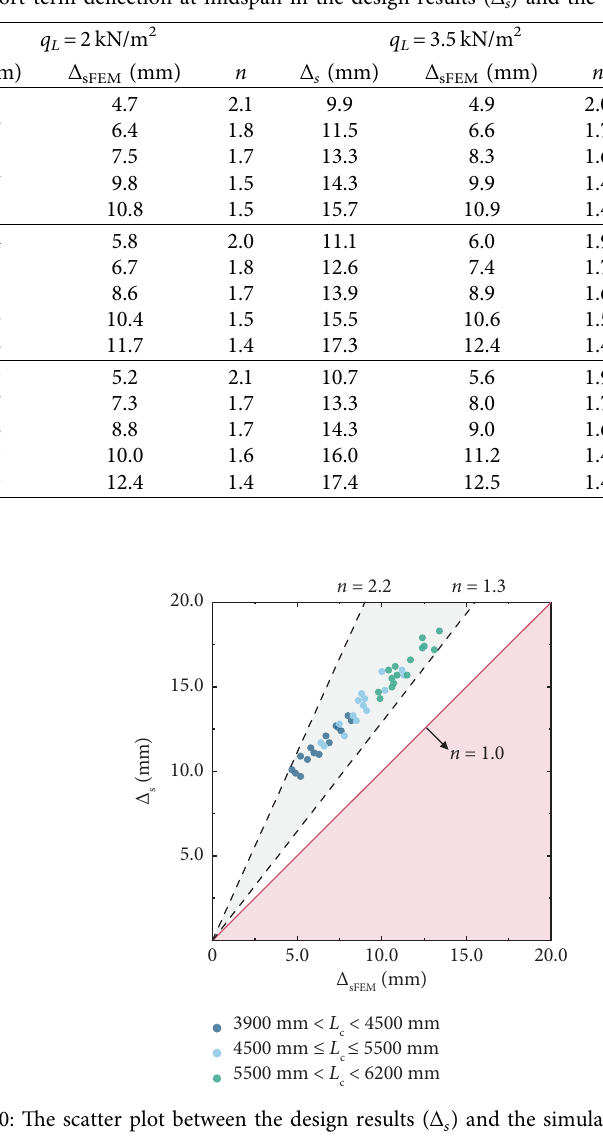
Table 5: Te short-term defection at midspan in the design results ( ∆